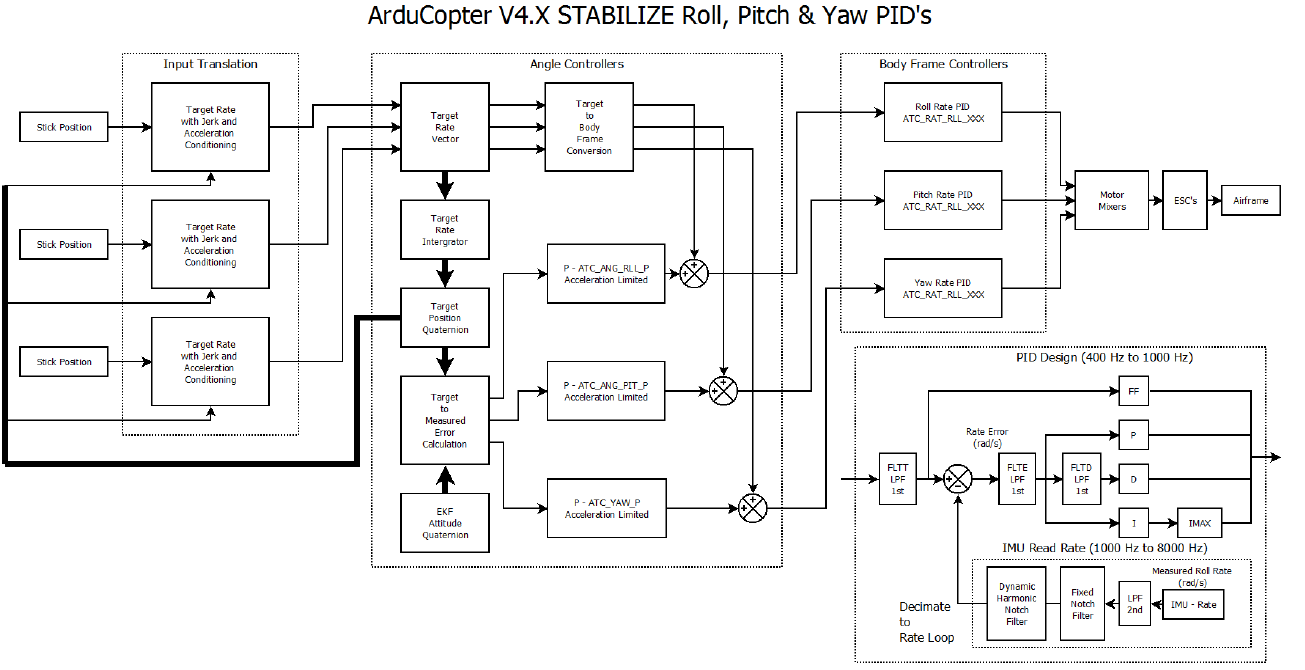
Figure 23. The structure of ArduCopter attitude controllers. Image source: https://ardupilot.org/ dev/docs/apmcopter-programming-attitude-control-2.html, accessed on 1 May 2022; published un- der the CC BY-SA 3.0 license: https://creativecommons.org/licenses/by-sa/3.0/legalcode, accessed on 1 May